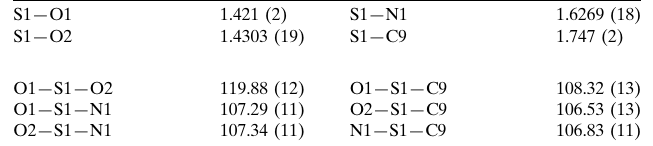
Selected geometric parameters (A˚ , (cid:1) ).